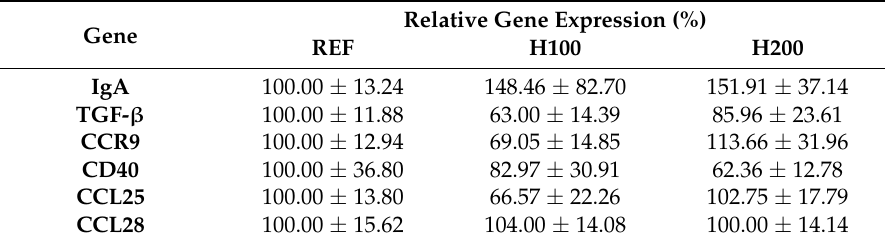
Table 3. Effect of hesperidin administration on gene expression of some molecules in small intestine. The relative mRNA gene expression was calculated assigning the value of 100% to the mean of the rats from the REF group. Data are expressed as mean ± standard error ( n = 5 − 6).